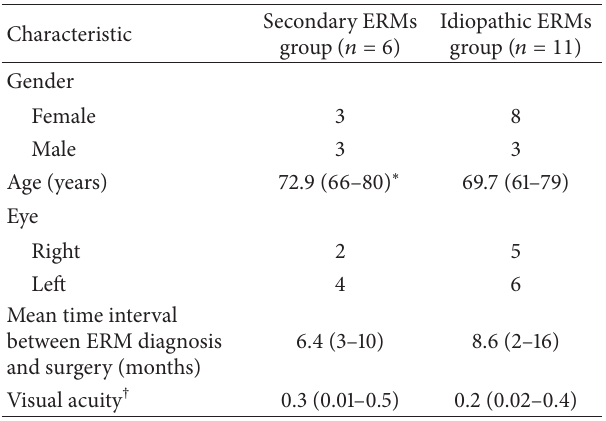
Table 1: Selected clinical features of patients with secondary ERMs after proliferative diabetic retinopathy and the control group with idiopathic